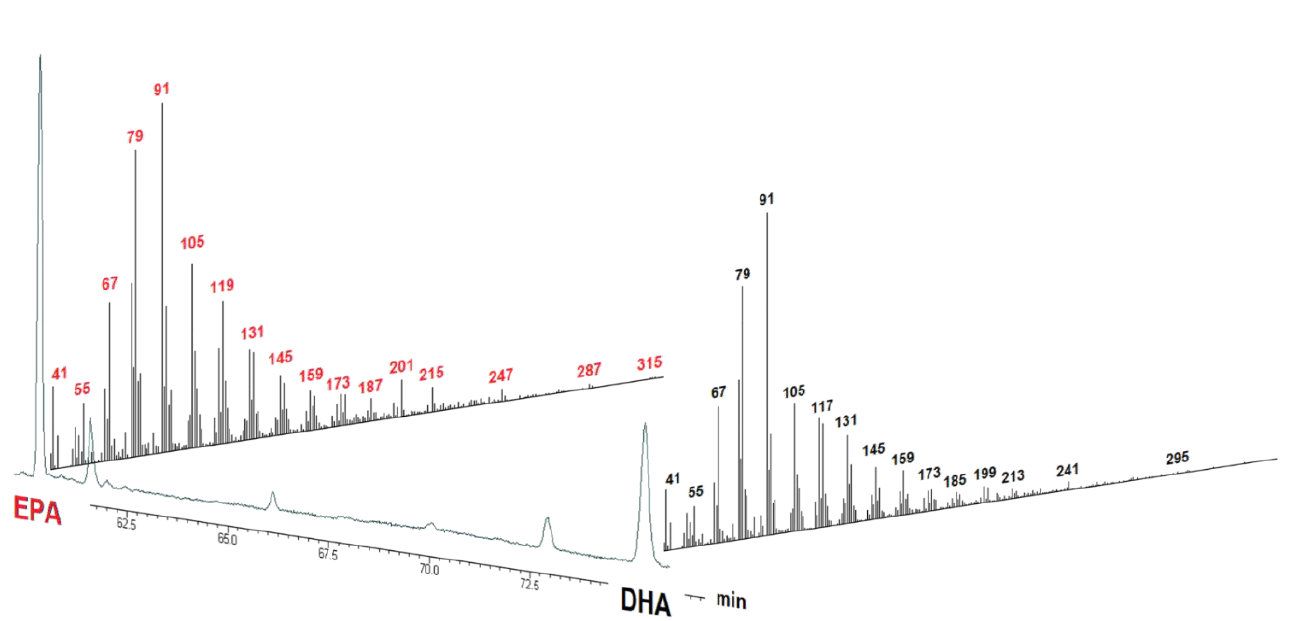
Figure 3. Supplement no. 2, GC-MS chromatogram in the time range 60–76 min, together with the mass spectra of EPA and DHA displayed in the third dimension.